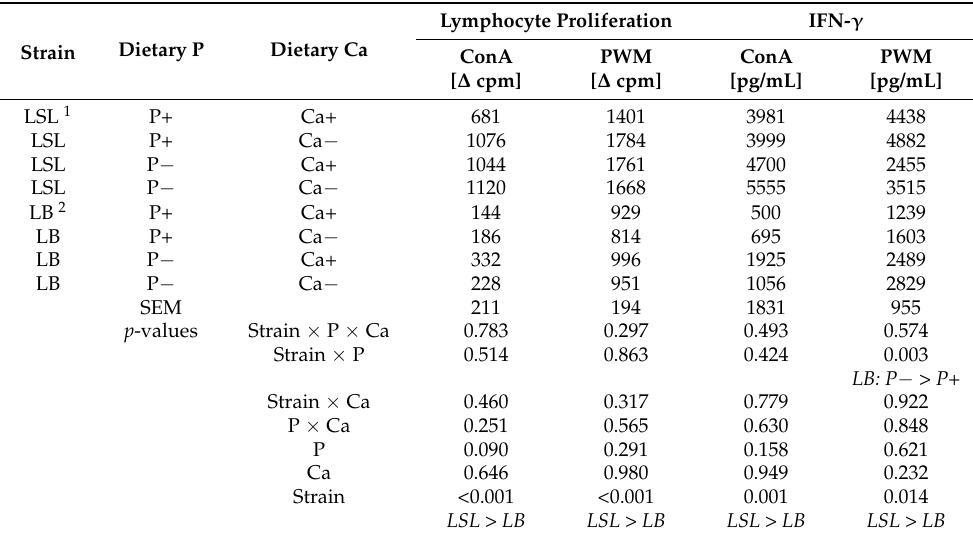
Table 5. Effect of strain, dietary P, and dietary Ca on lymphocyte proliferation capacity and IFN- γ concentrations of